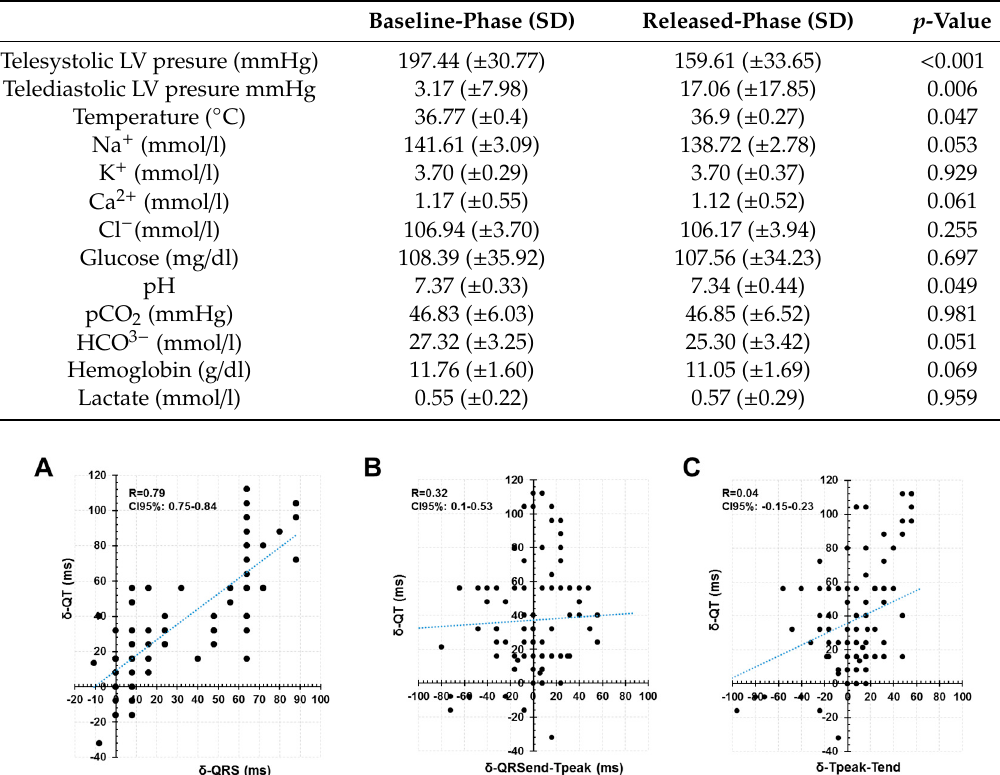
Figure 3. Correlation of δ -QT with regard to δ -QRS, δ - the interval from the ending of the QRS to the peak of the T wave (QRSend-Tpeak) and δ - the interval from the peak of the T wave to the end of the T wave (Tpeak-Tend). See text for discussion.